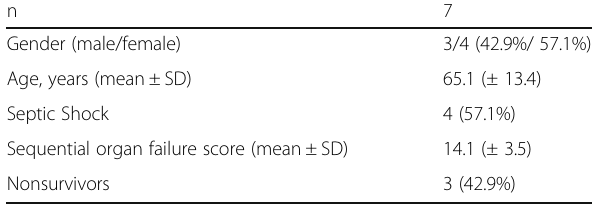
Table 1 miRNA Microarray: Characteristics of Sepsis